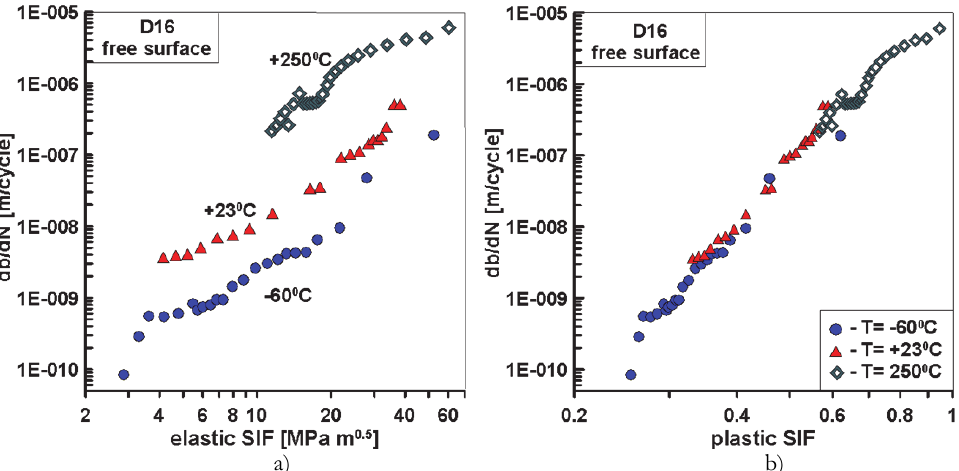
Figure 10: Crack growth rate as a function of (a) elastic and (b) plastic SIFs for free surface of the specimen. The same trend observed for the deepest point of the crack front (Fig. 11a,